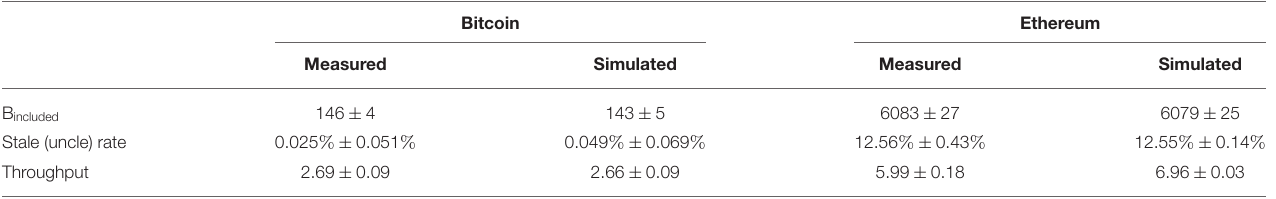
TABLE 3 | Validation of the simulator results by comparison with measurements from Bitcoin and Ethereum.